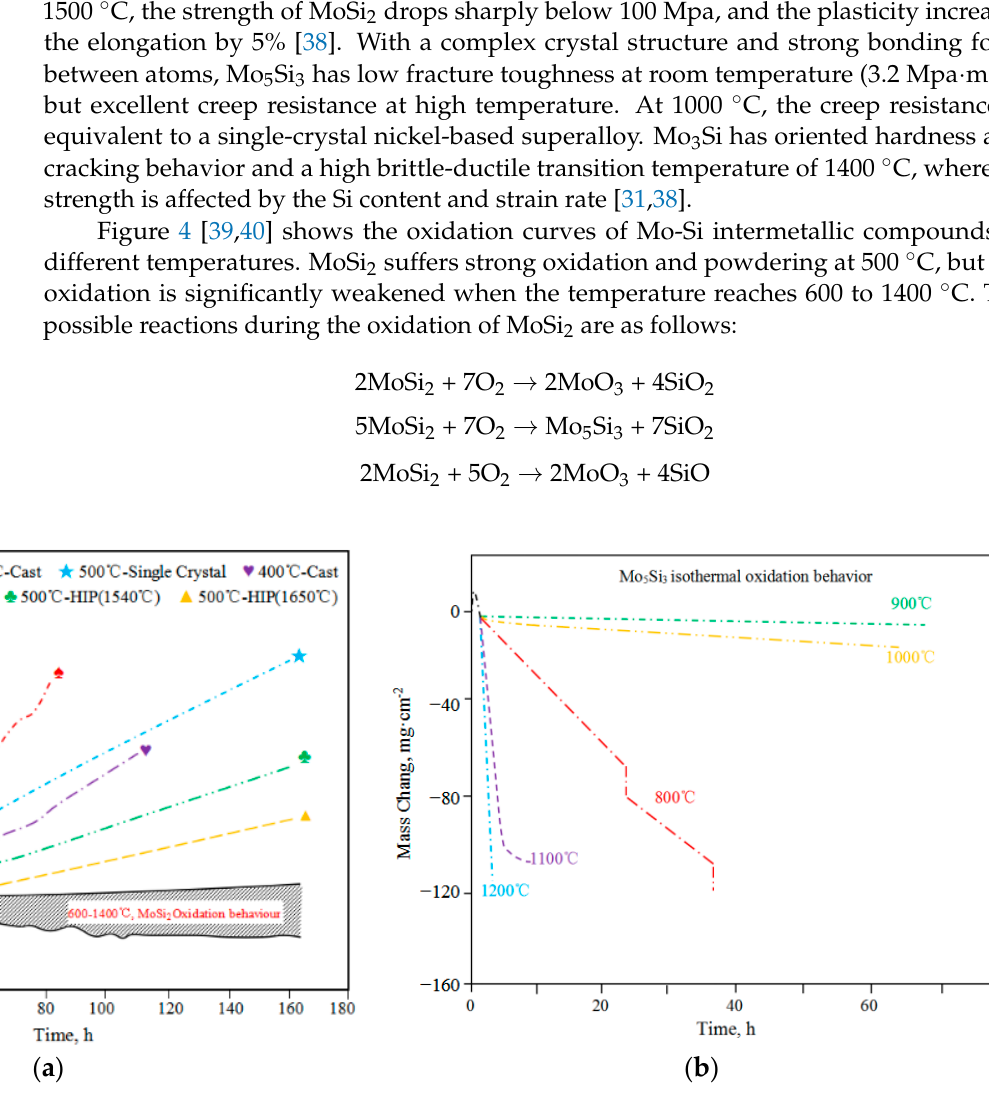
Figure 5. Variation of MoSi 2 sample morphology with oxidation temperature and oxidation time: ( a ) unoxidized; ( b ) 400 °C, 23 h; ( c ) 450 °C, 23 h; ( d ) 500 °C, 21 h; ( e ) 550 °C, 70 h; ( f ) 600 °C, 100 h; ( g ) 675 °C, 20 h [41]. 3. Modification of Mo-Si Series Intermetallic Compounds 3.1. Alloying Research Alloying could achieve toughness reinforcement and performance optimization of Mo-Si series intermetallic compounds. Alloying mainly includes microalloying and